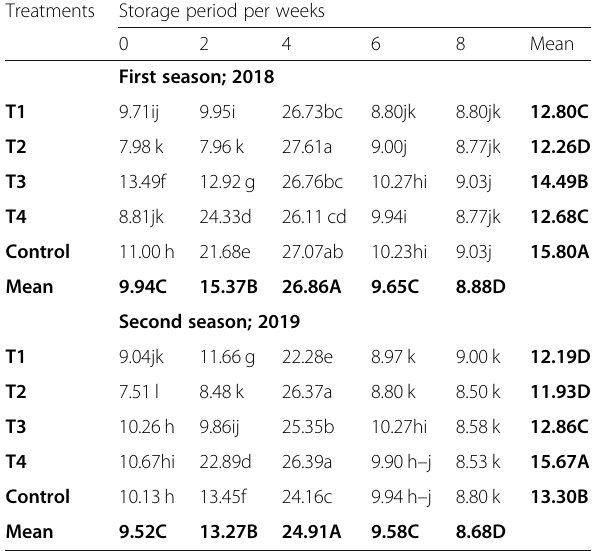
Table 6 Effect of preharvest spraying with moringa leaf extract, boric acid, and chelated calcium on total anthocyanin content of Hollywood plum fruits stored at 0 ± 1 °C and RH 85 –